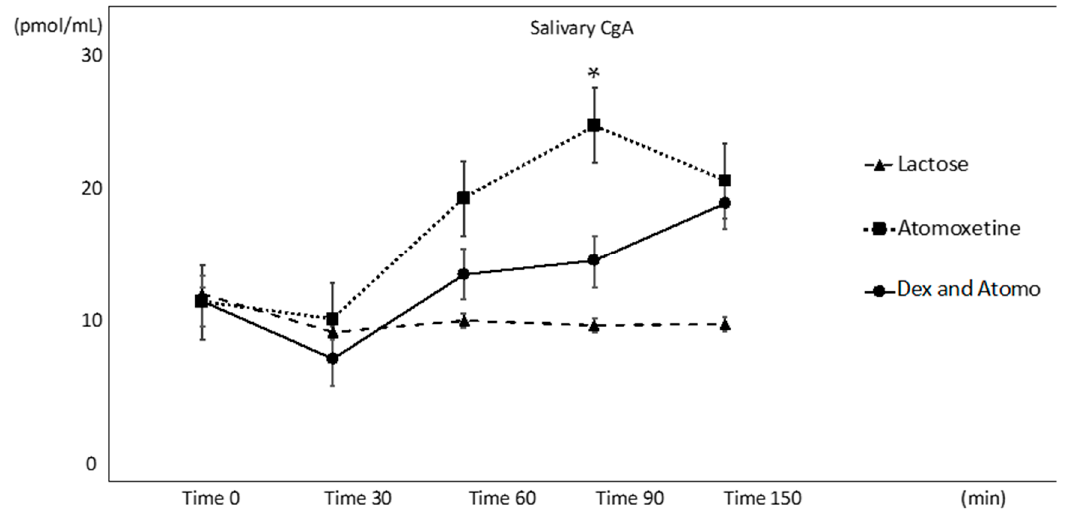
Figure 1. Salivary CgA response to three treatments. Error bars reflect SEM. Asterisk indicate. p <